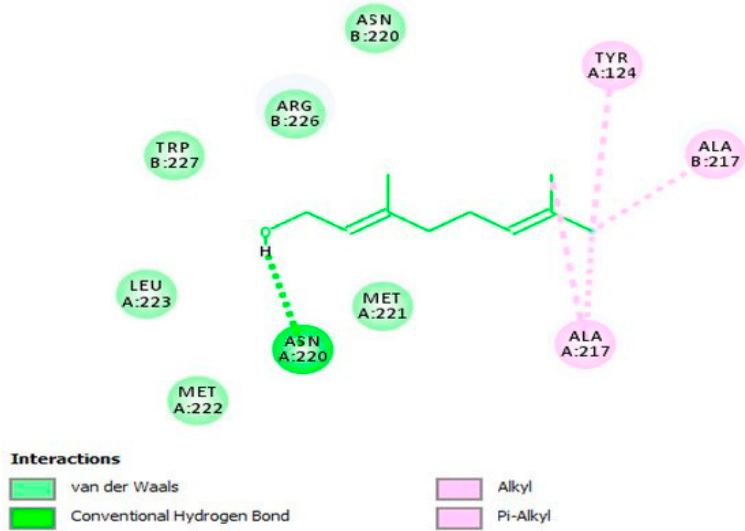
Figure 6. The two-dimensional (2D) interaction diagram of 62 in the active cavity of HSV-2 protease. Only those amino acid residues implicated in the enzyme stabilization are exposed. Hydrogen